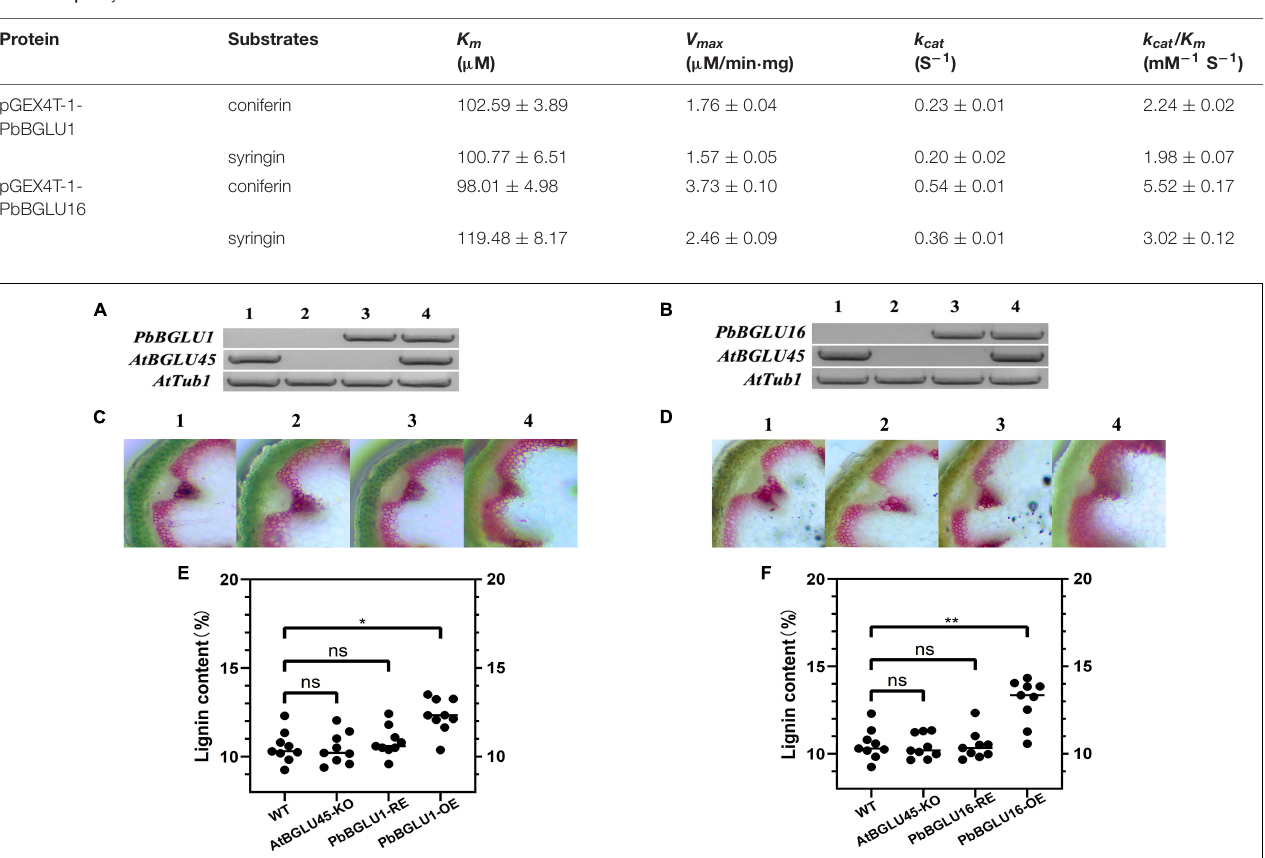
FIGURE 7 | The lignin content in inflorescence stems of Arabidopsis. (A) PCR analysis of Arabidopsis thaliana wild type (A-1,B-1) ; AtBGLU-45 mutant (A-2,B-2) ; AtBGLU-45 mutant lines rescued by PbBGLU1 and PbBGLU16 (A-3,B-3) ; PbBGLU1 and PbBGLU16 overexpressing Arabidopsis (A-4,B-4) . (C,D) Cross-sections of the inflorescence stem were stained with phloroglucinol–HCl; (C-1,D-1) Wild-type (WT) plants; (C-2,D-2) BGLU45 knock out mutant plants; (C-3,D-3) PbBGLU1 and PbBGLU16 rescue plants; (C-4,D-4) Over-expression PbBGLU1 and PbBGLU16 plants. (E,F) Measurement of the lignin content in inflorescence stems of Arabidopsis thaliana . The bar = 100 µ m. (* P < 0.05, ** P < 0.01). KO, knock out; RE, rescue; OE, over expression.